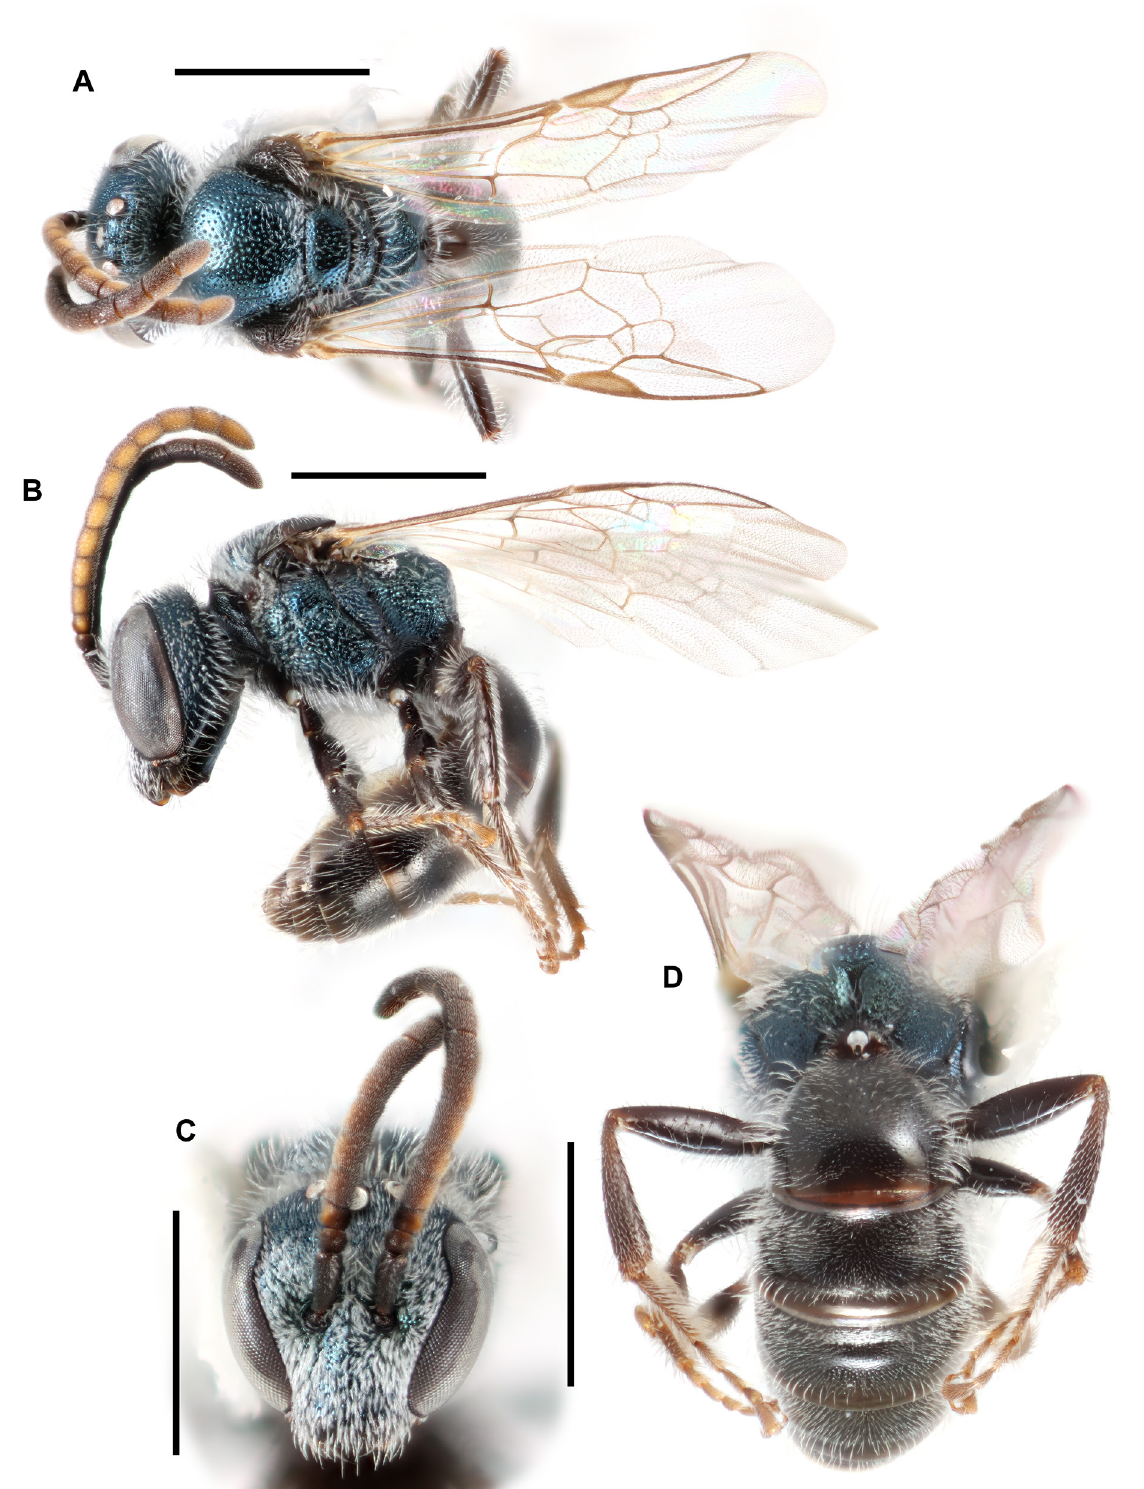
Fig. 4. Lasioglossum ( D .) angelicum sp. nov., ♂ (LACM ENT 394542). A . Dorsal habitus. B . Lateral habitus. C . Face. D . Metasoma. Scale bars = 1